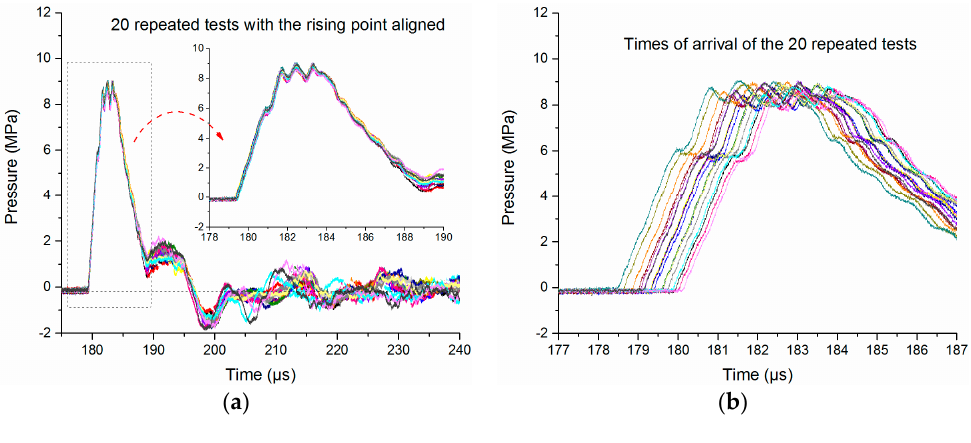
Figure 4. Cont. Figure 4.